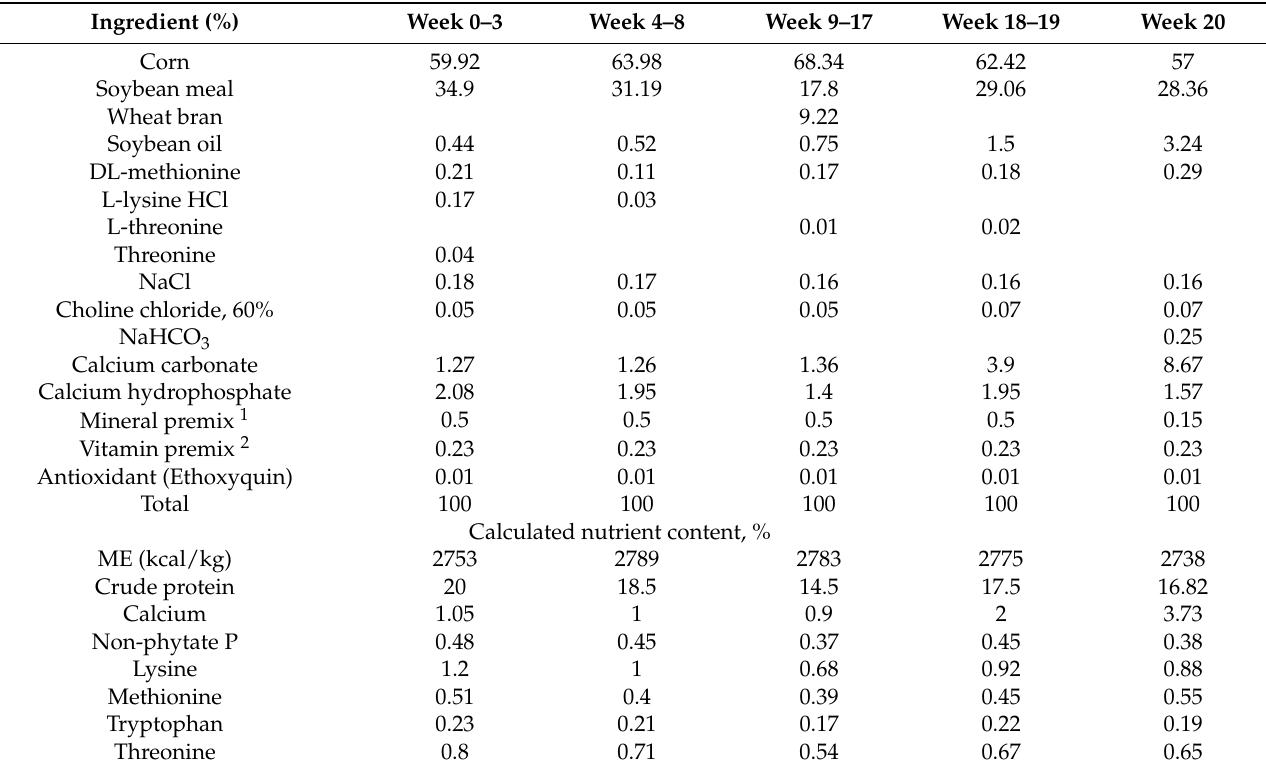
Table 1. Basal diet composition and nutrient